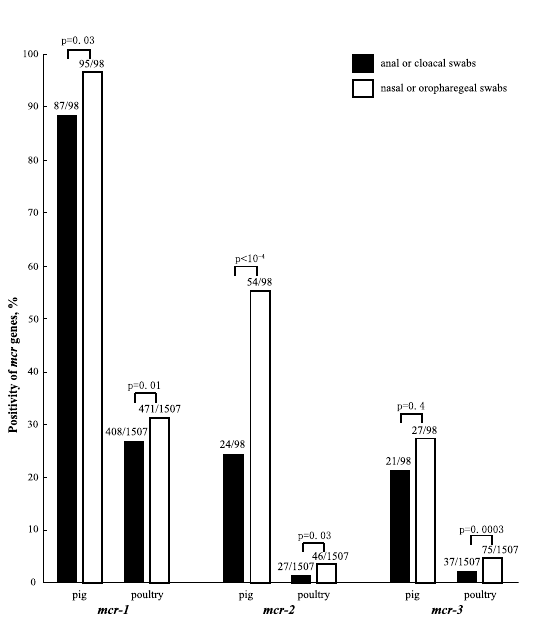
Figure 3. Prevalence of mcr-1 , mcr-2 and mcr-3 in the initial and terminal alimentary system of pigs and poultry. Swabs from both initial and terminal alimentary systems were collected from 98 pigs and 1,507 poultry in this study. For all three mcr genes in swabs from pigs and mcr-1 and mcr-2 in swabs from poultry, the prevalences in nasal/oropharyngeal were significantly higher than in the anal /cloacal